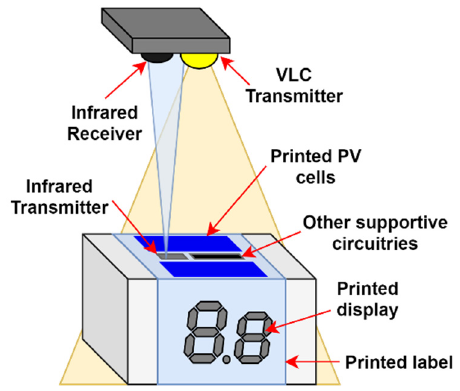
Figure 3. LIoT-based product smart label design.